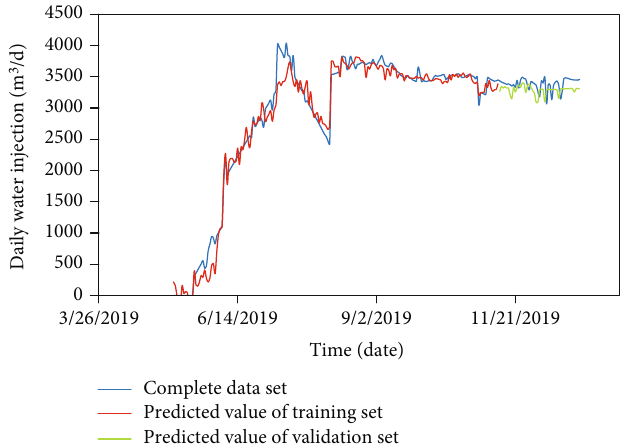
Figure 9: Forecast results of the multi-input production dynamic forecasting